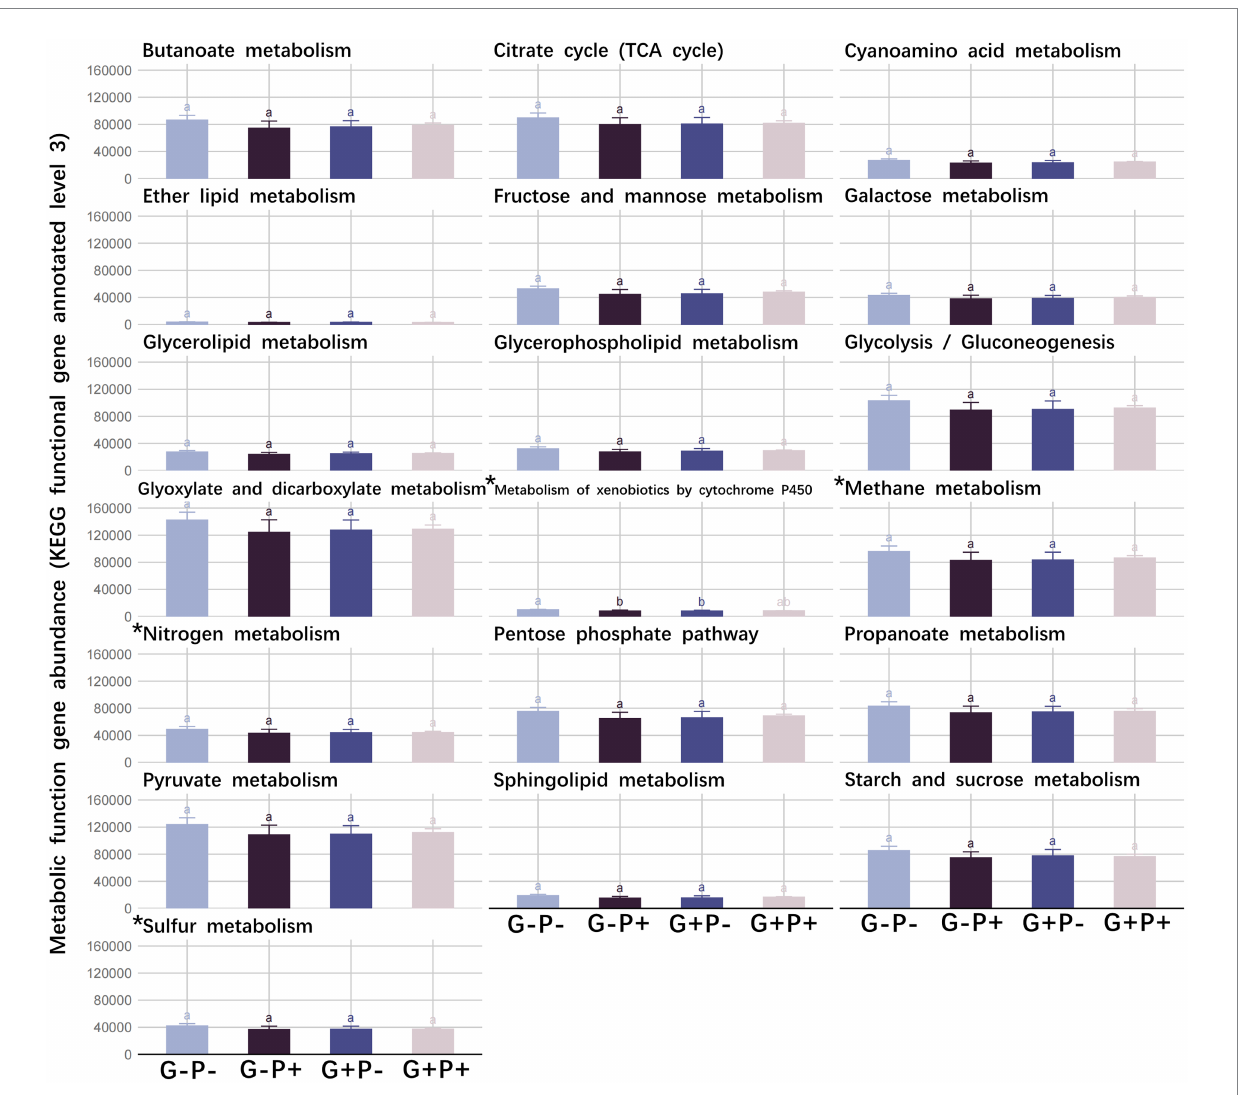
FIGURE 1 The abundance of functional genes of 15 broad metabolic functions and four specialized metabolic functions under four grazing by P-addition treatments. Means and standard errors are shown. Tukey’s honestly significant difference test was performed under analysis of variance (ANOVAs), with different lowercase letters referring to significant differences between treatments (value of p < 0.05). *Represents specialized metabolic